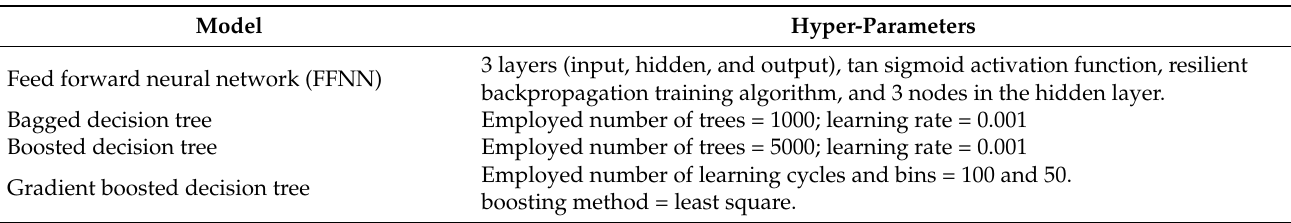
Table 1. Machine learning model